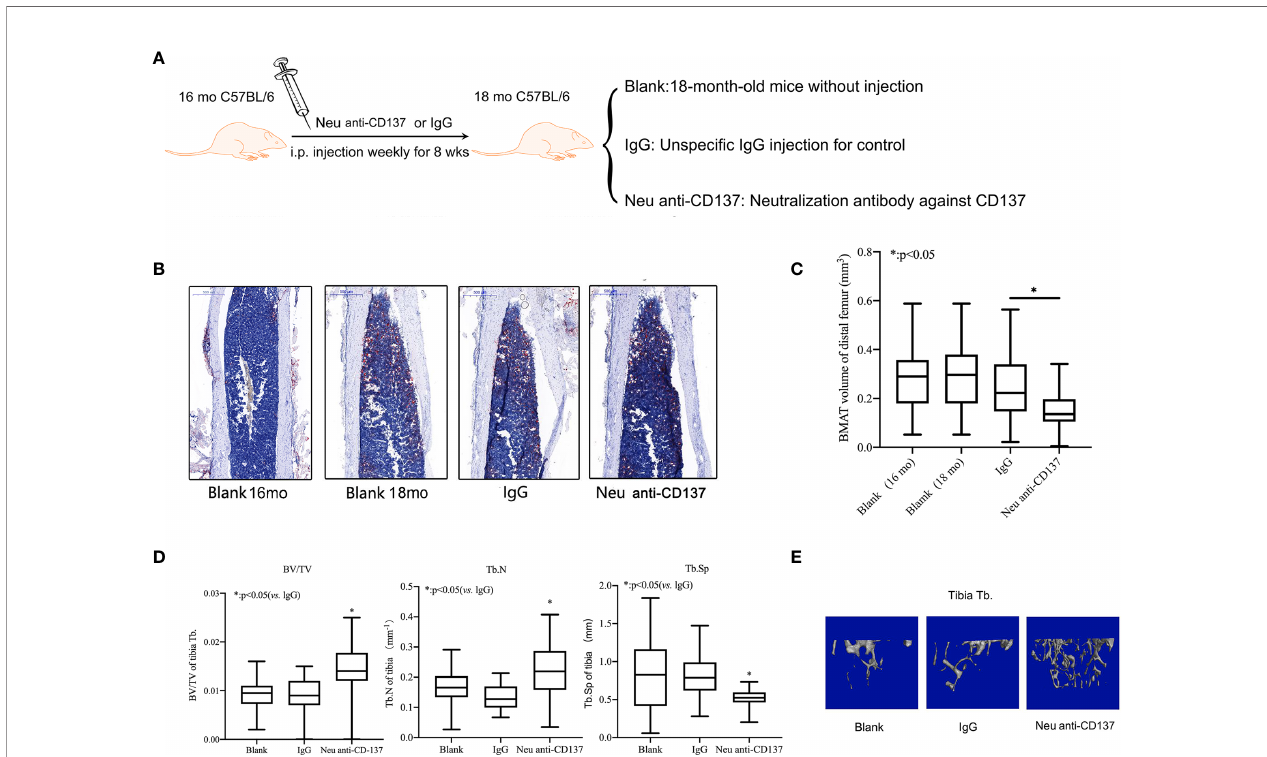
FIGURE 4 | Alleviatation of trabecular bone loss and inhibition of bone marrow adipogenic differentiation in aged mice via blocking of CD137 signaling in vivo . (A) The 16-month-old C57BL/6 mice were intraperitoneally injected with neutralization antibody against CD137 once a week for 8 weeks. (B) Oil red-O stain of the medullary cavity of femur for intra-bone marrow in mice. (C) A morphometric analysis in the volume of bone marrow adipose tissue. (D) BV/TV, Tb.N, and Tb.Sp of the proximal tibia from 18-month-old mice with and without neutralization antibody against 4-1BB were determined by micro-CT. (E) Representative 3D reconstruction images of the proximal tibia Tb. All the data were obtained from three independent experiments. Data are shown as the means ± SEMs. *p < 0.05.